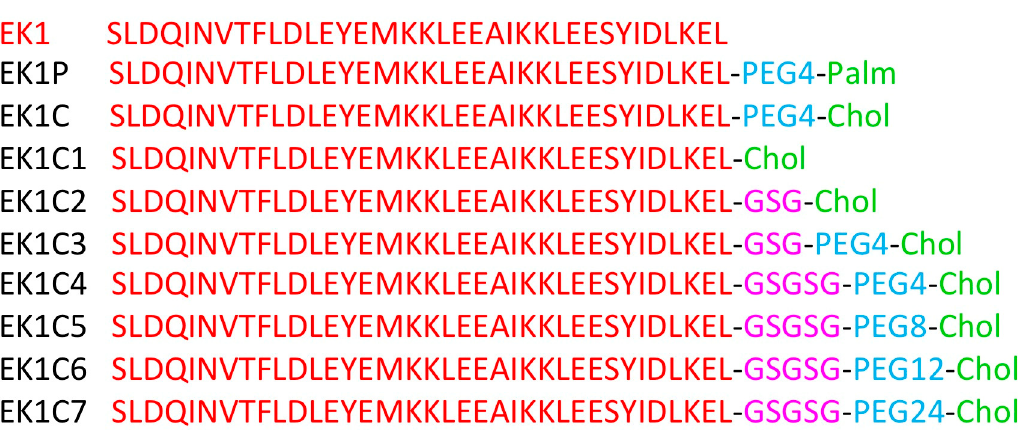
Figure 8. Amino acids sequences of EK-1 and its lipopeptide derivatives.